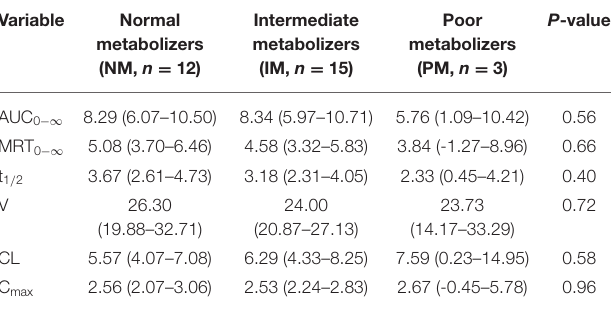
TABLE 3 | Comparison of esomeprazole PK parameters with various CYP2C19 metabolic phenotype.